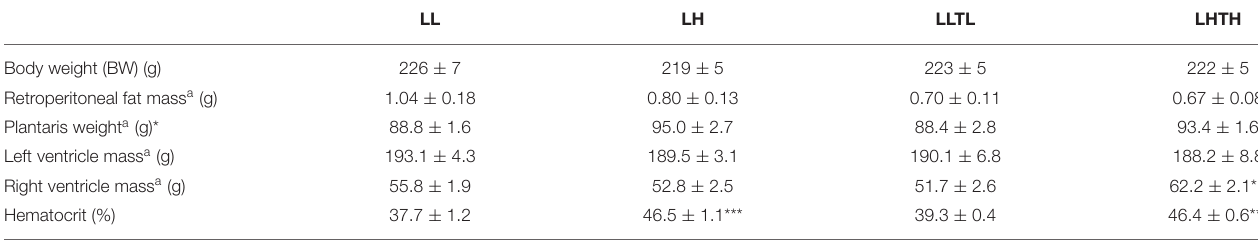
TABLE 2 | Anatomical data parameters and hematocrit at the end of